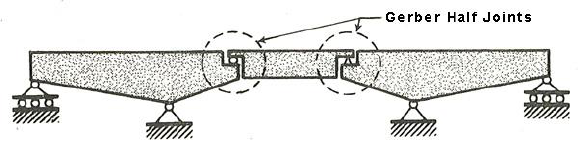
Figure 2. The structural scheme of the bridge with two Gerber half joints inside the central span.